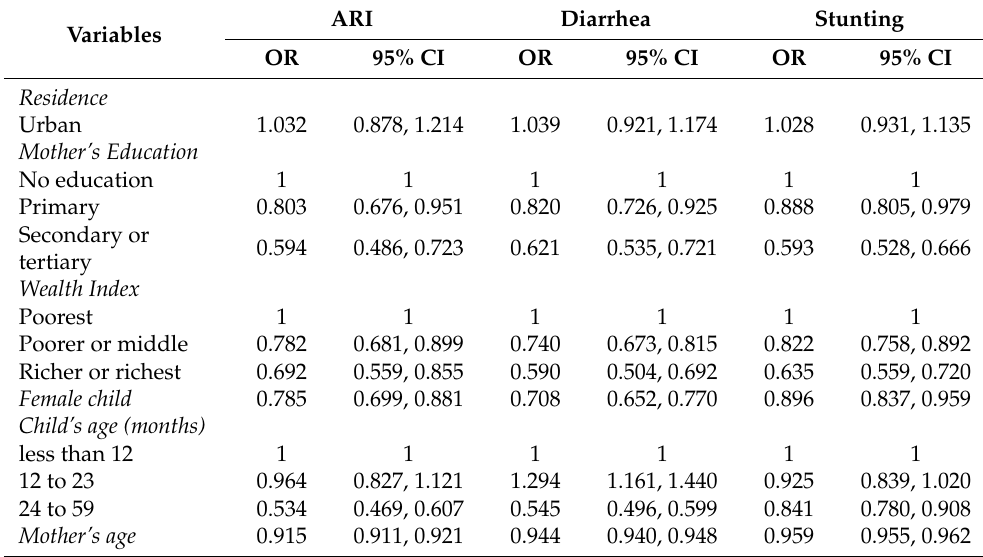
Table 4. The odds ratio estimates of the covariate effects and their 95% credible interval for 2008. Variables